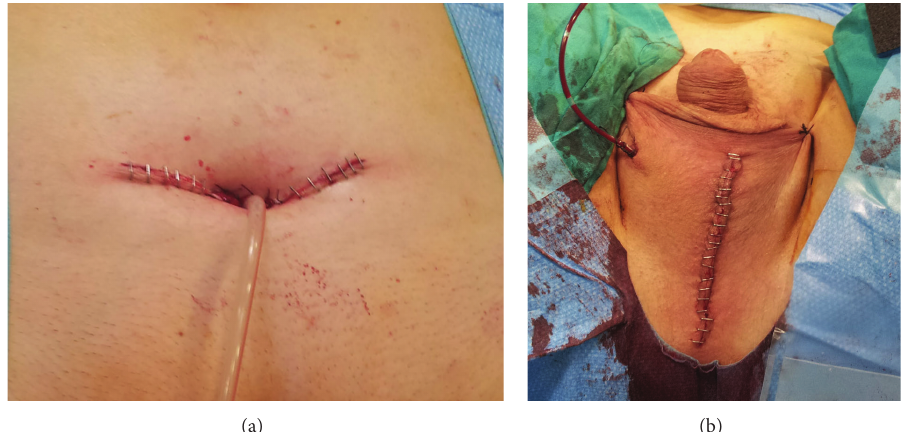
Figure 5: Postoperative appearance. (a) Final appearance of vesicostomy. (b) Final appearance of incision for subalbuginea orchiectomy and